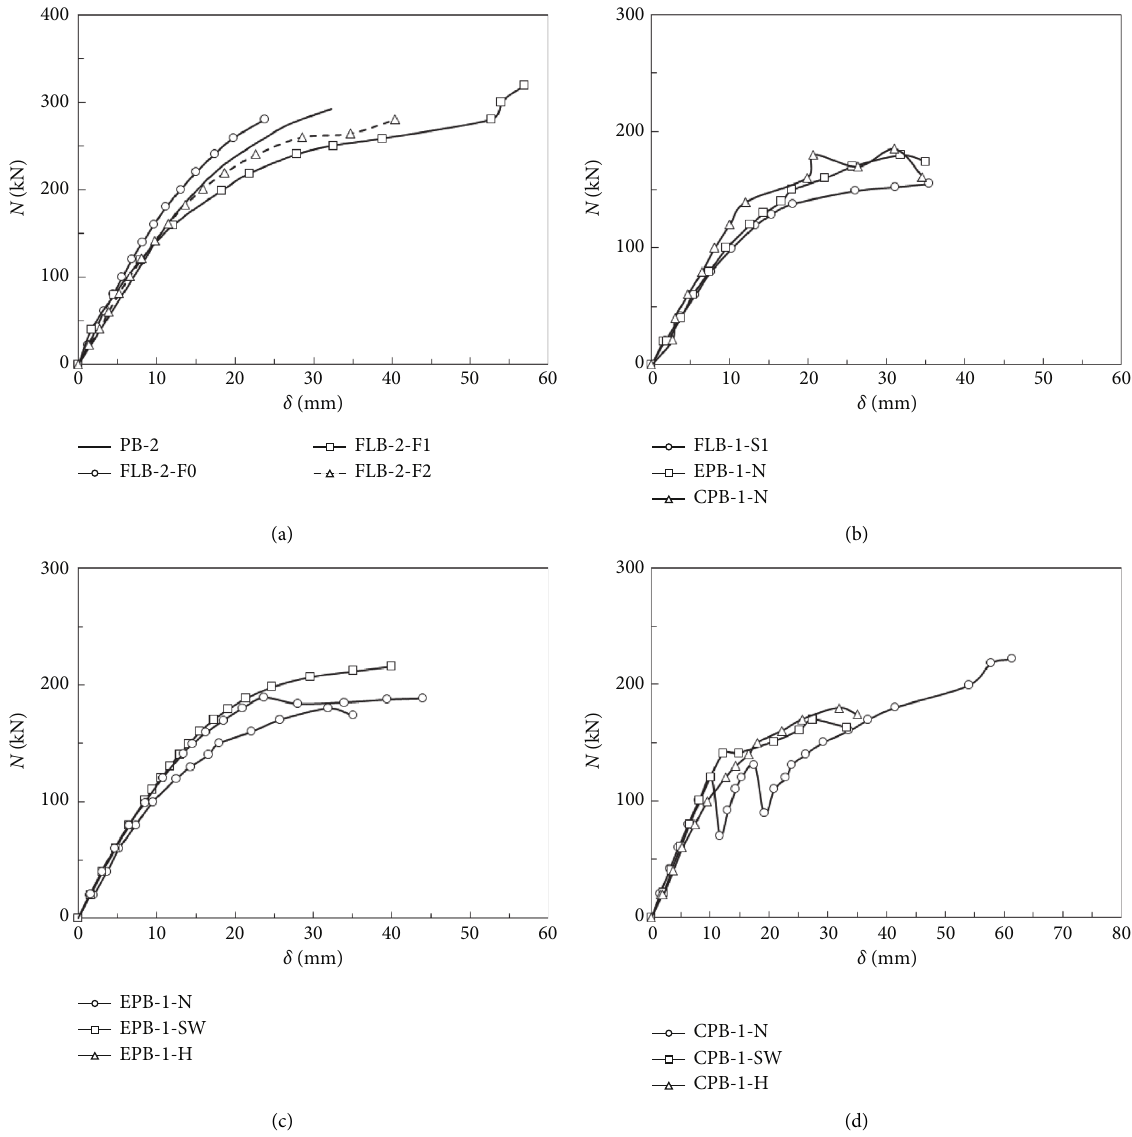
Figure 10: Influence of tested parameters on the load-vertical displacement curves. (a) EDB-spliced type (pure bending). (b) Spliced type (midspan loading). (c) Bolt types (EPB specimens). (d) Bolt types (CPB the initial loading stage, θ increases linearly with the in- the measured points of 5# and 6# displacement transducers creasing M , followed by the rapid increase of rotation de- (Figure 5(b)): formation beyond the yield load. For the FLB specimens, the D − D (cid:0) 􏼁 5 6 . ( 1 ) θ � thickness of filled plates has little influence on the initial L r stiffness despite the slight improvement observed in speci- men FLB-2-F2. However, the deformability of specimens The moment ( M ) versus rotation angle ( θ ) curves for with filled plates is significantly improved. specimens under pure bending are shown in Figure 11. At